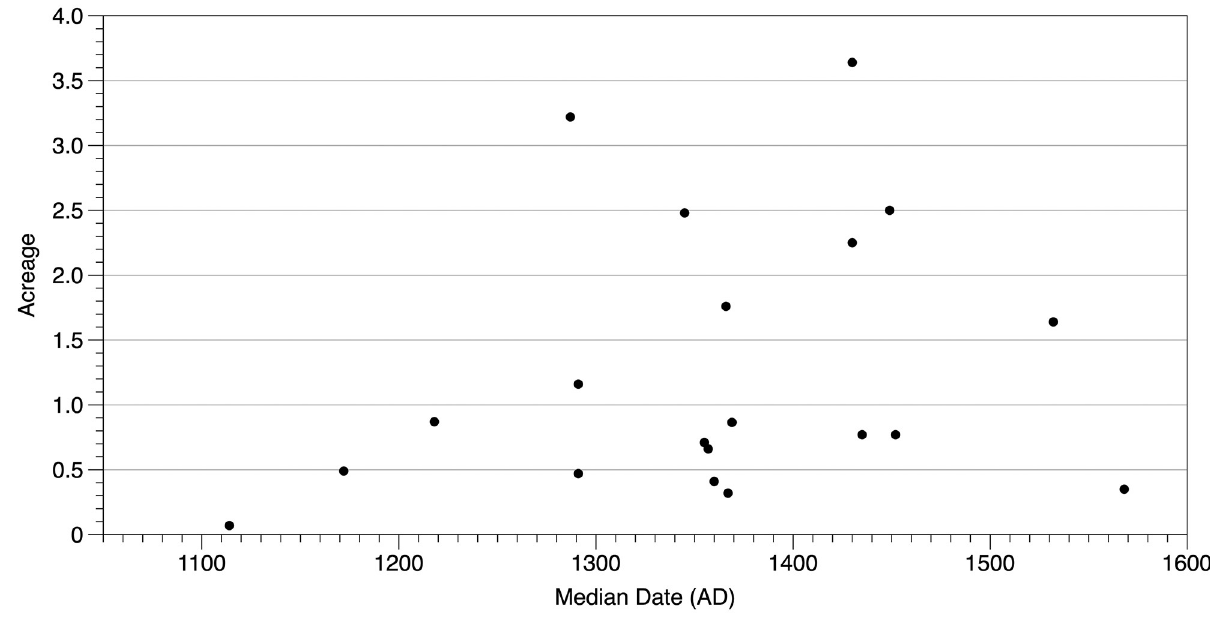
Fig 3. Site acreage by median of the Date